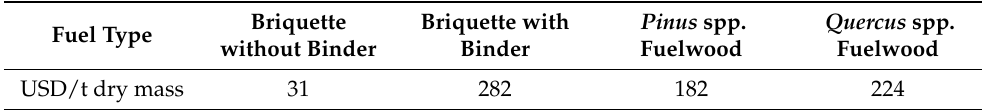
Table 2. Costs of the briquettes type and conventional fuelwood. Fuel